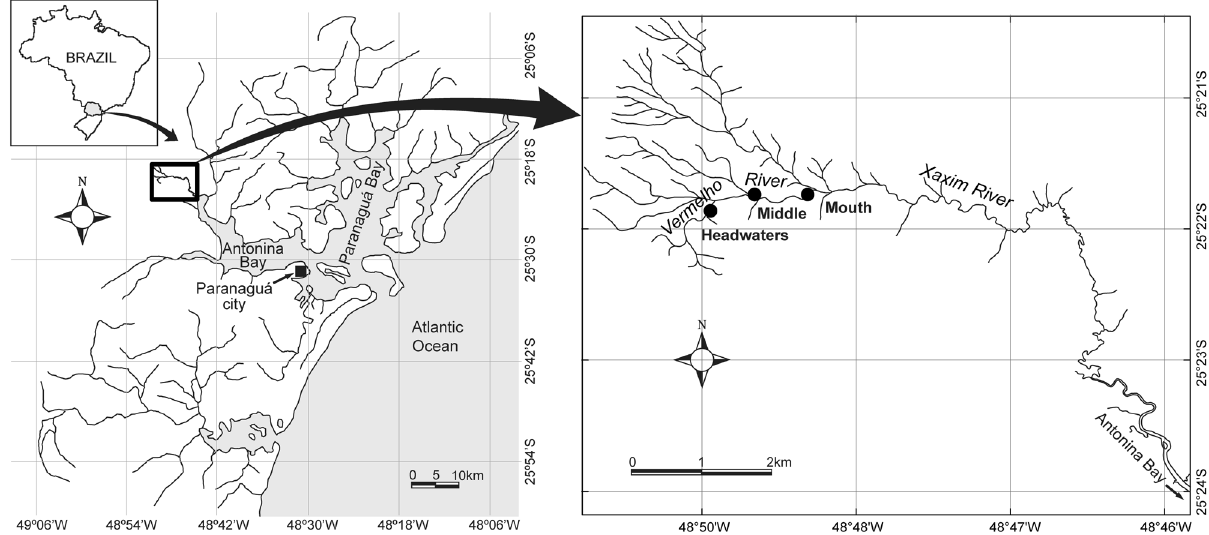
Figure 1. Location of the Vermelho River, eastern Atlantic basin, Antonina, Paraná state, Brazil. Black circles indicate the sampling reaches; arrow indicates the flow direction. Source: PEREIRA Jaime Luiz Lopes,